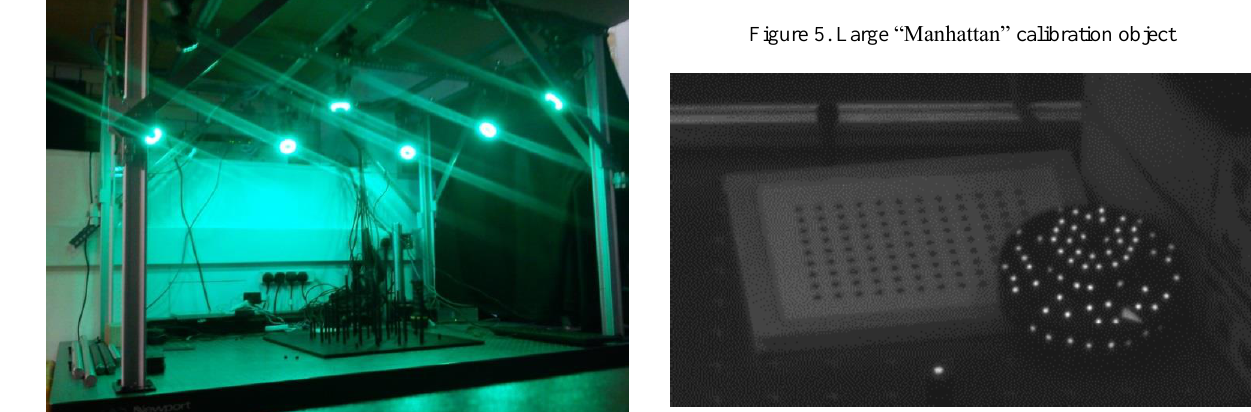
Figure 4. 6DoF Tracking Rig